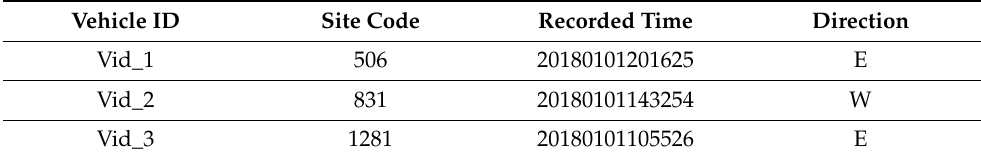
Table 2. Sample data of